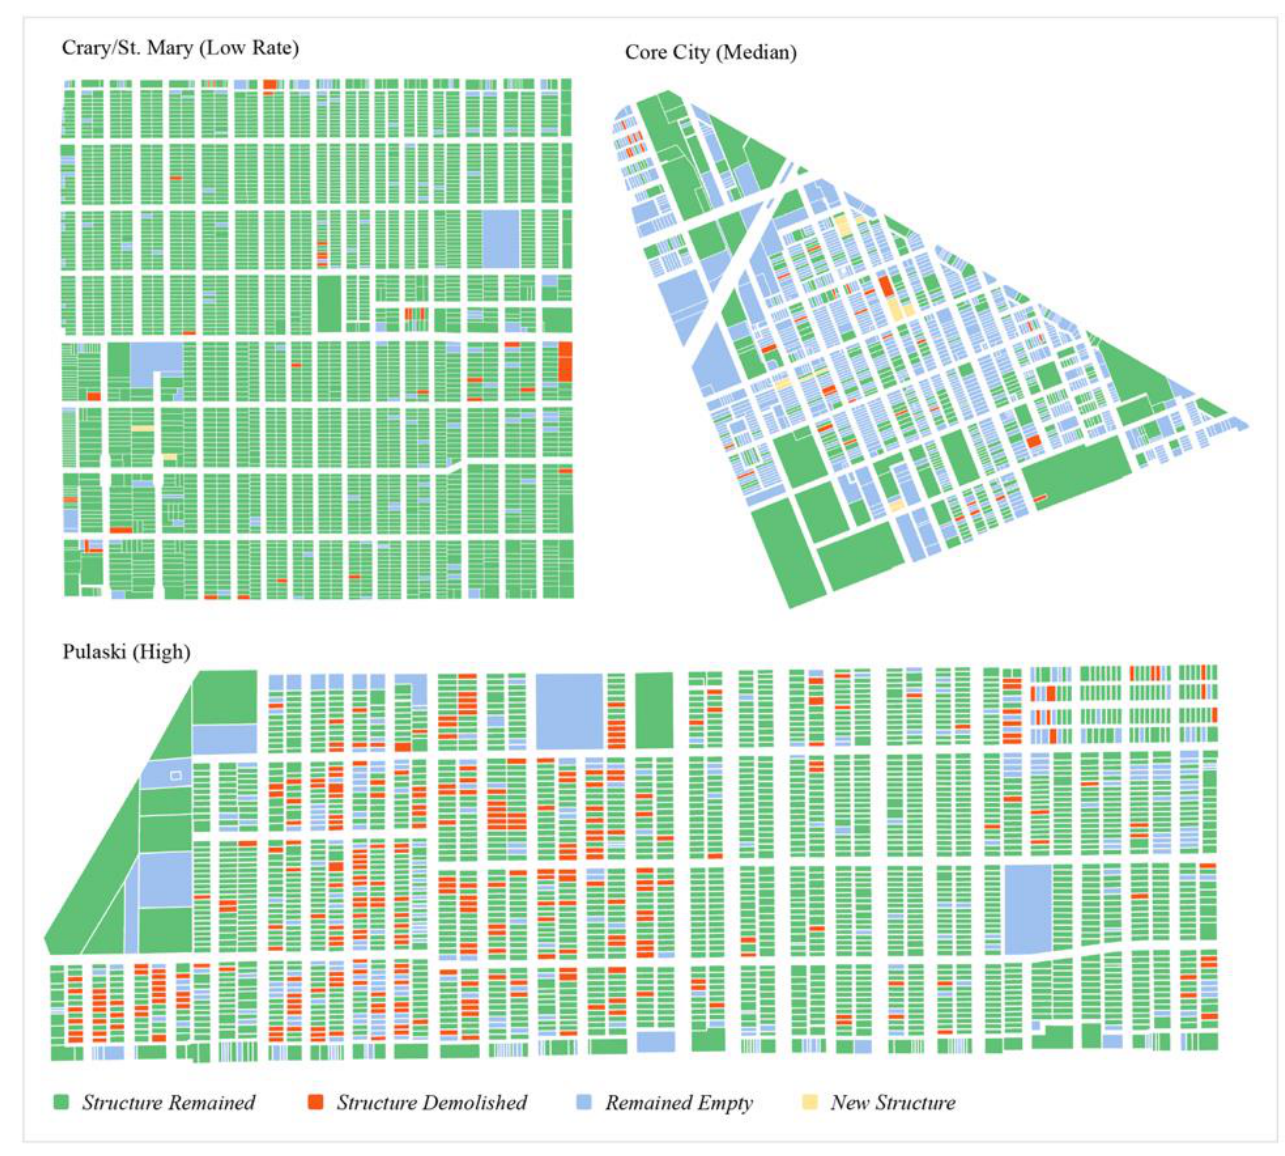
Figure 12. Three areas of interest, change detection: NAIP 2018–NAIP 2014. Table 7. Residential structure detection by parcel lot—accuracy comparison.